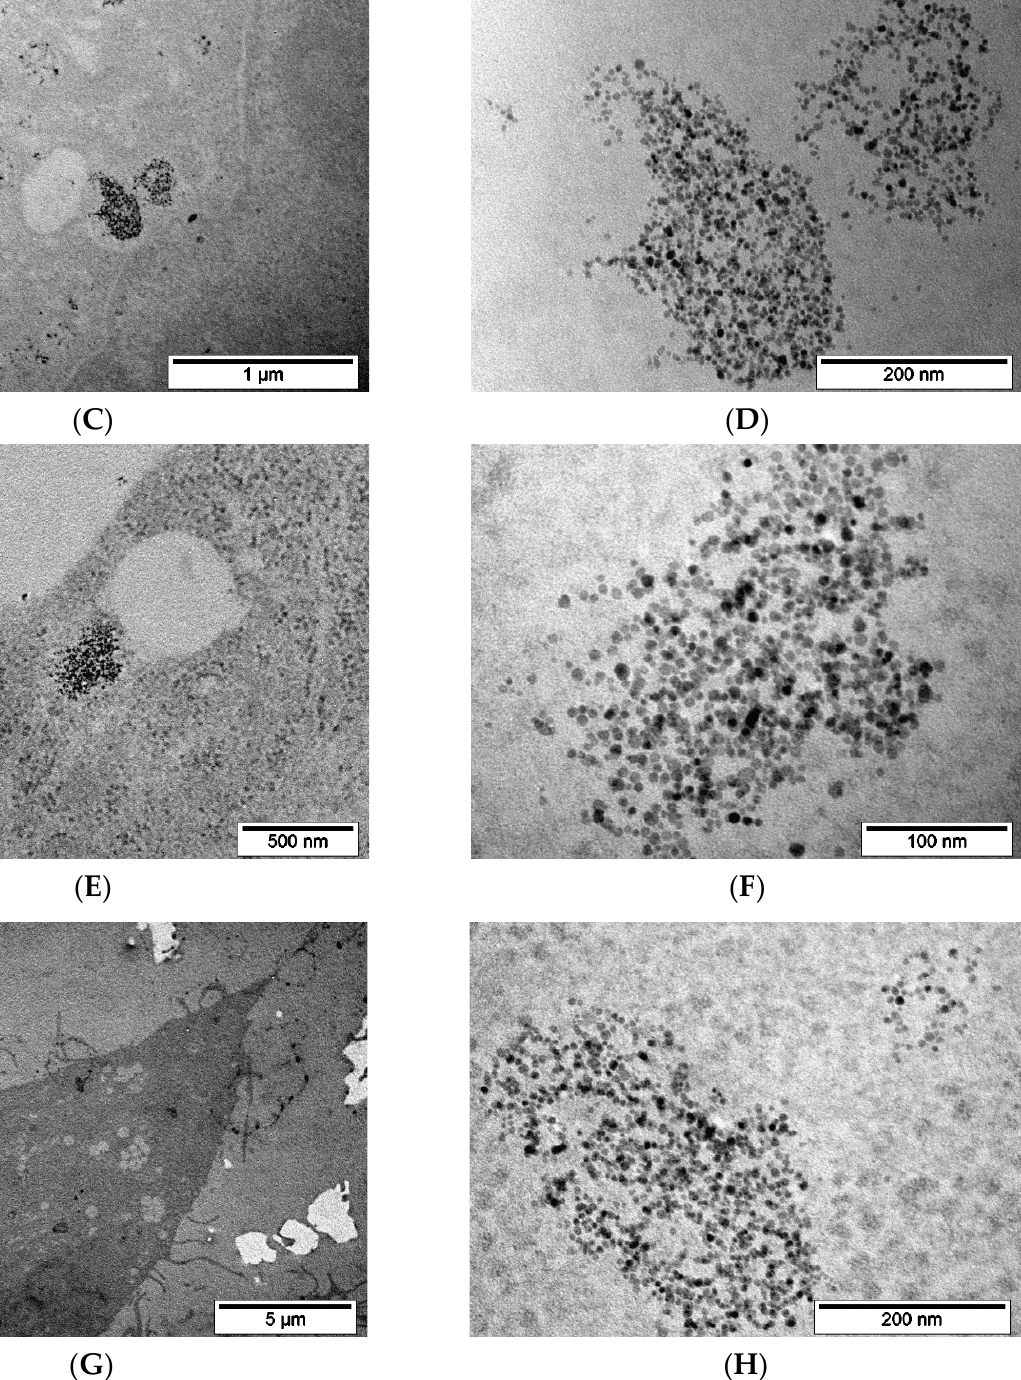
Figure 9. TEM images of the PC-3 cells after 24 h incubation with MNP-SS ( A – D ) or MNP-PEG: ( A ) — the outer cell membrane and a vesicle with numerous MNP-SS nanoparticles; the vesicle is enlarged in ( B , C ) — the low magnification overview of PC-3 cell with a lot of vesicles filled with MNP-SS nanoparticles; the vesicle is enlarged in ( D , E , G ) — PC-3 cells cytoplasm with a lot of vesicles filled with MNP-PEG nanoparticles; ( F , H ) — enlarged frames of ( E , G ), correspondingly.